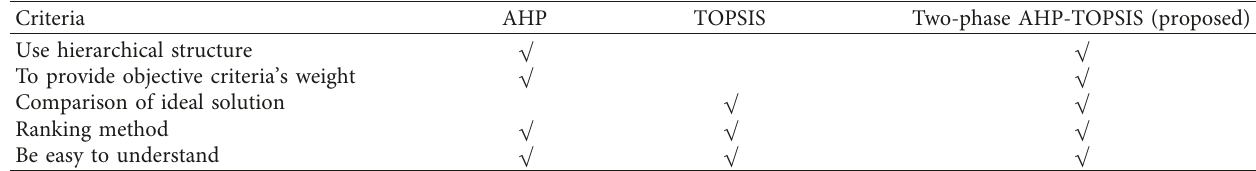
Table 1: Comparison of proposed with individual AHP and TOPSIS methods [18].